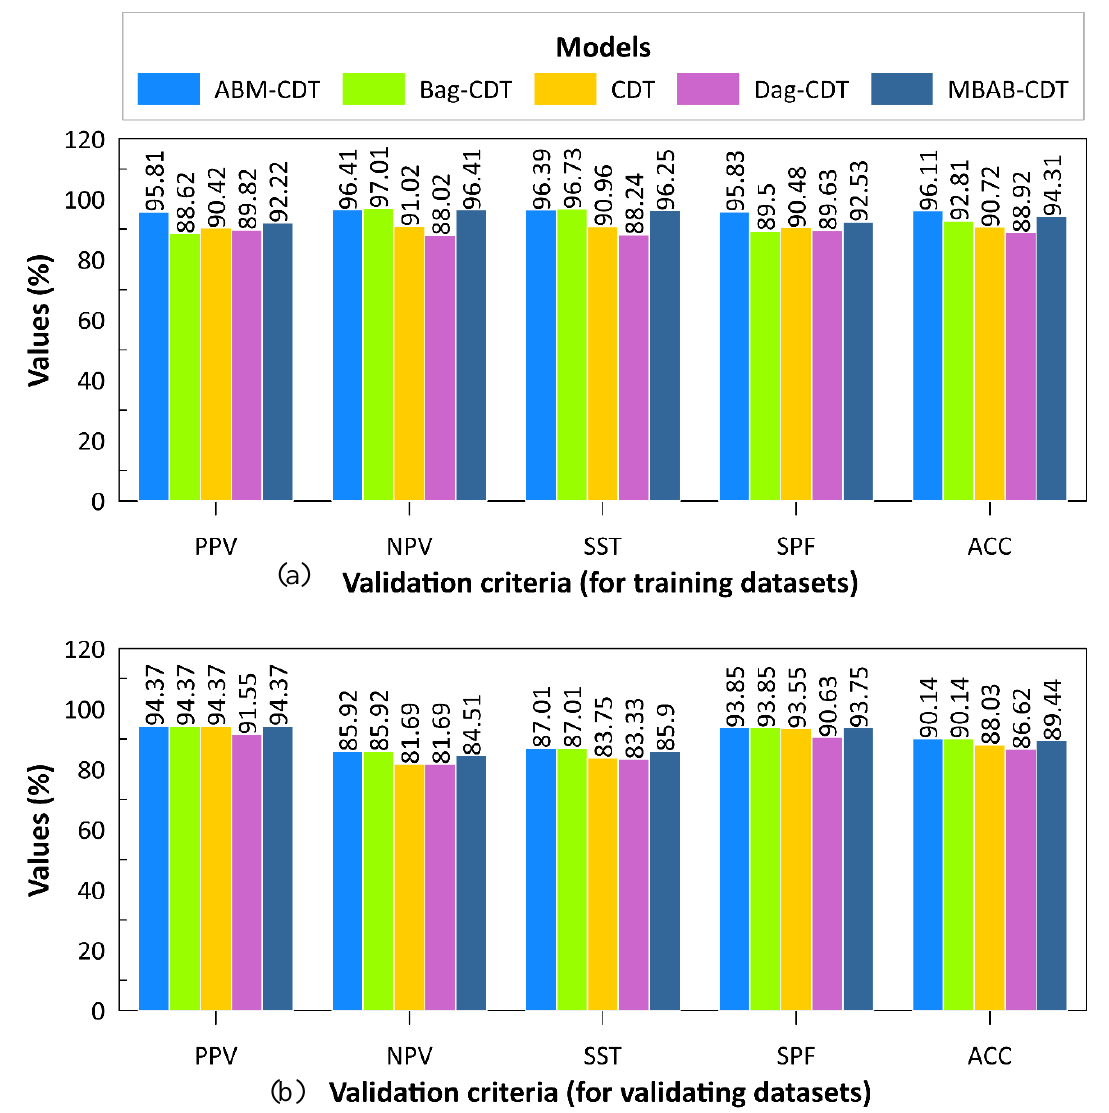
Figure 8. Analysis of accuracy of the models using: ( a ) training dataset and ( b ) validating dataset.